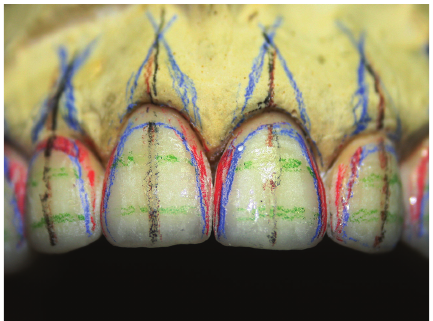
Figure 2: Prepared teeth.